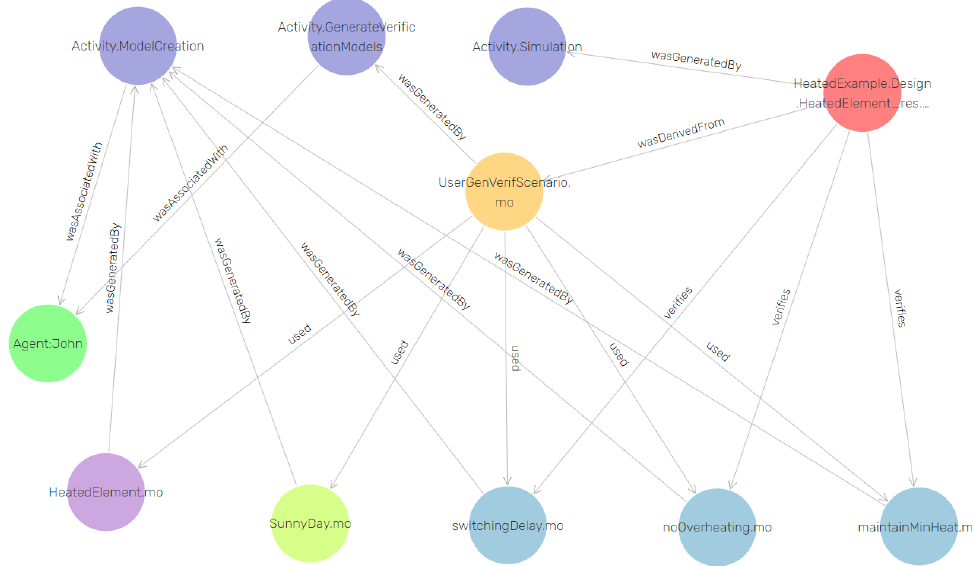
Figure 10. An example of traceability links between artifacts visualized in the GraphDB